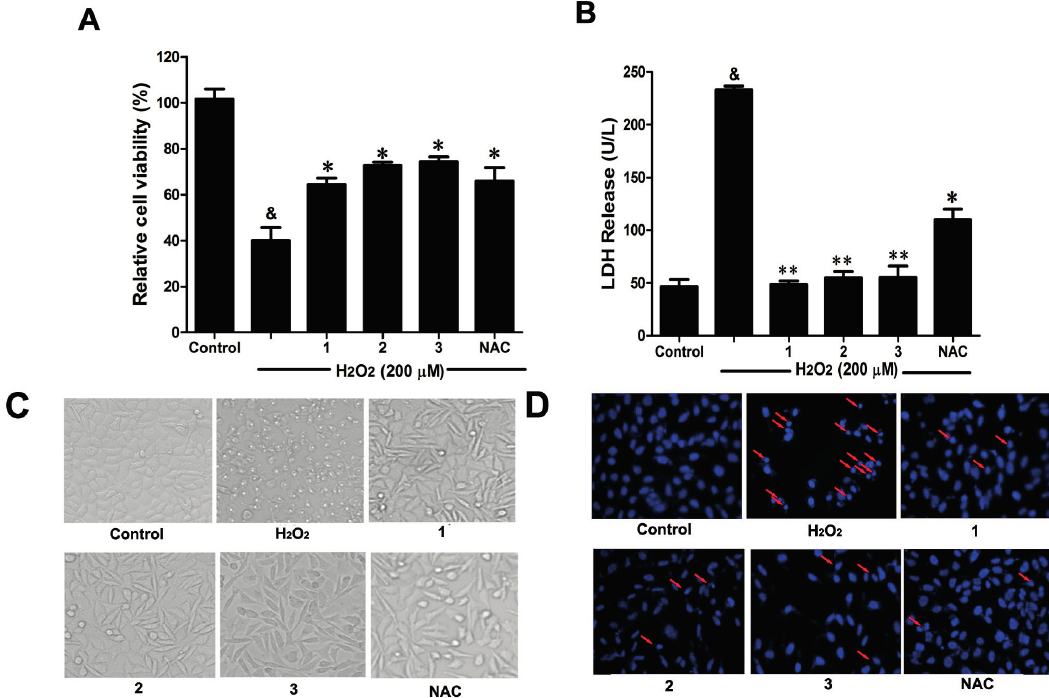
Figure 3. Effects of Danshensu-cysteine conjugates on H 2 O 2 -induced cellular